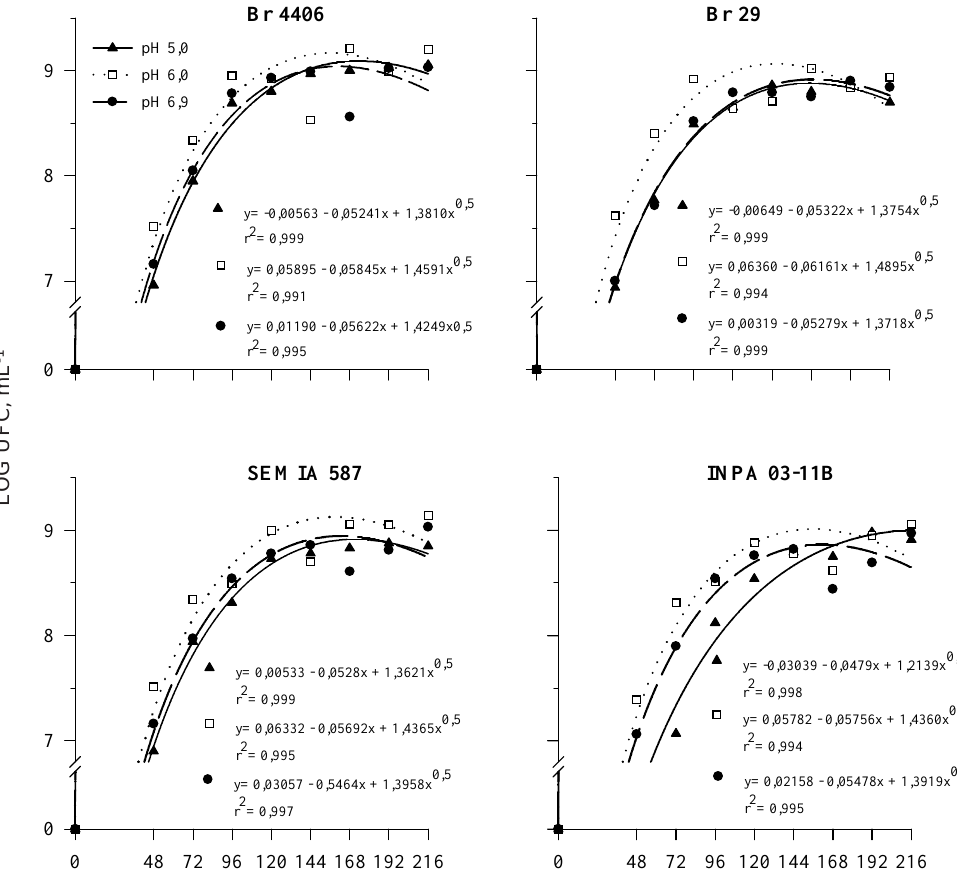
Figura 1. Comportamento de estirpes de Bradyrhizobium em meio líquido, considerando o pH de